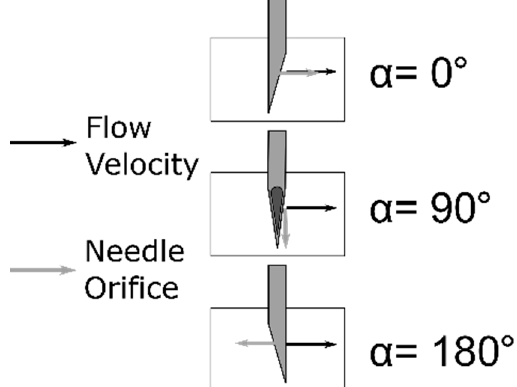
Figure 2. Schematic illustration of different needle orifice orientations relative to the flow. The angle between the needle orifice and the flow velocity is described by α .